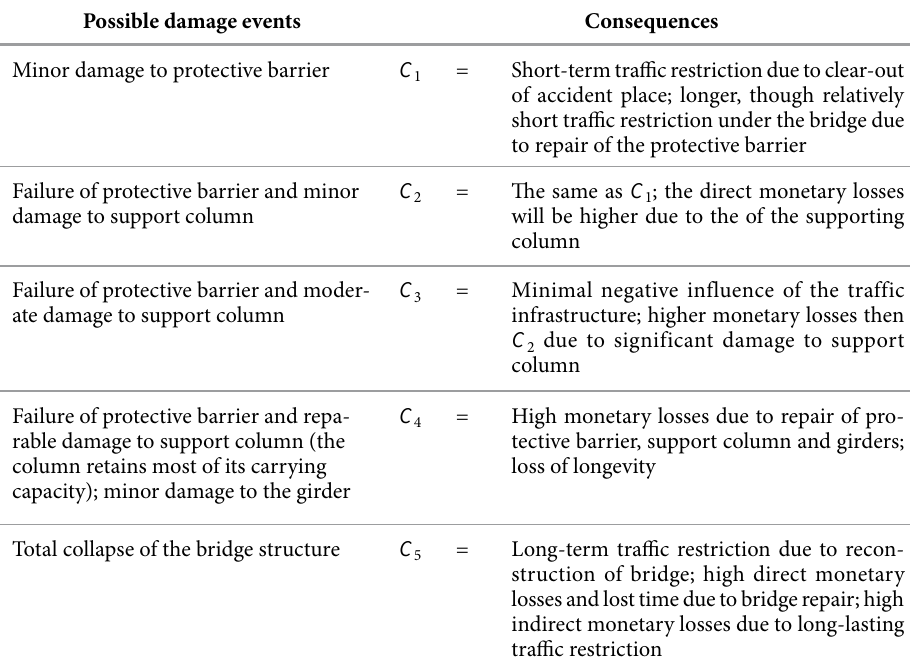
table 3. Damage events D i and consequences C i likely to occur due to vehicle collision with the bridge ( i = 1, 2, … , 5) possible damage events consequences